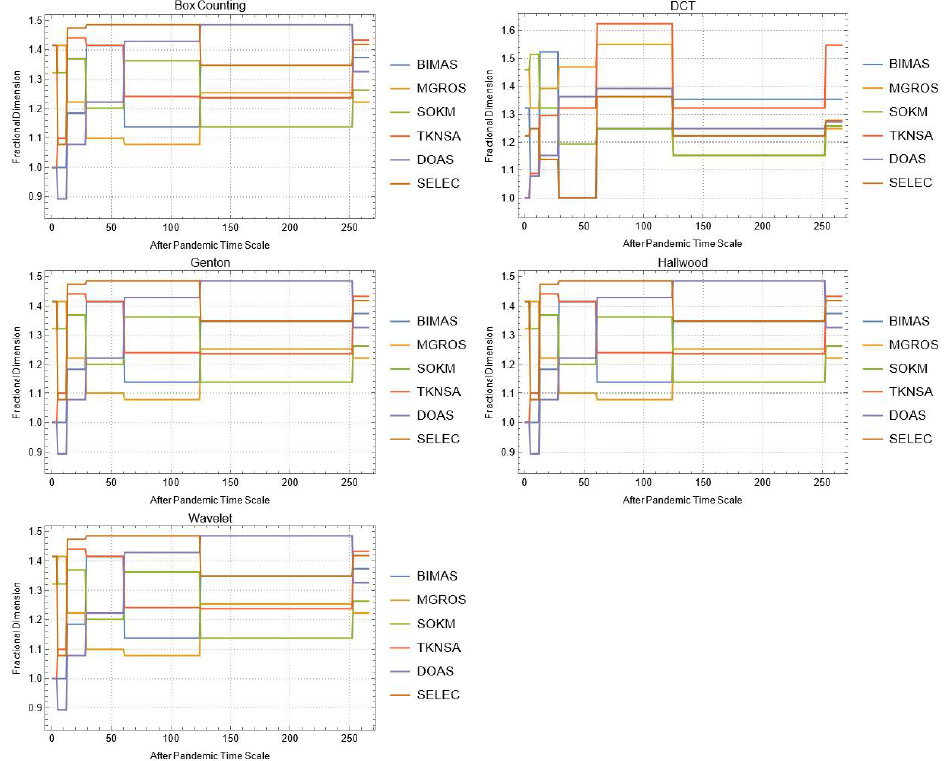
Figure A27. Daily changes of fractal dimensions after the pandemic (wholesale–retail).